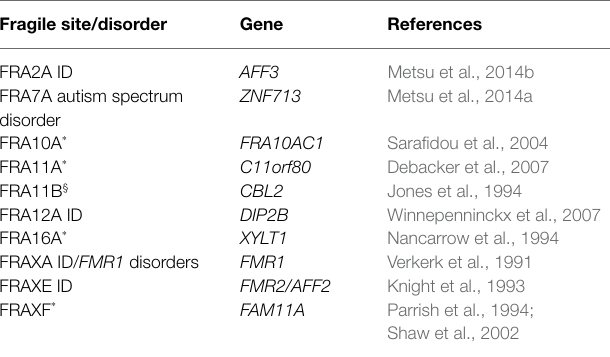
TABLE 1 | Folate-sensitive rare fragile sites known to be associated with CGG